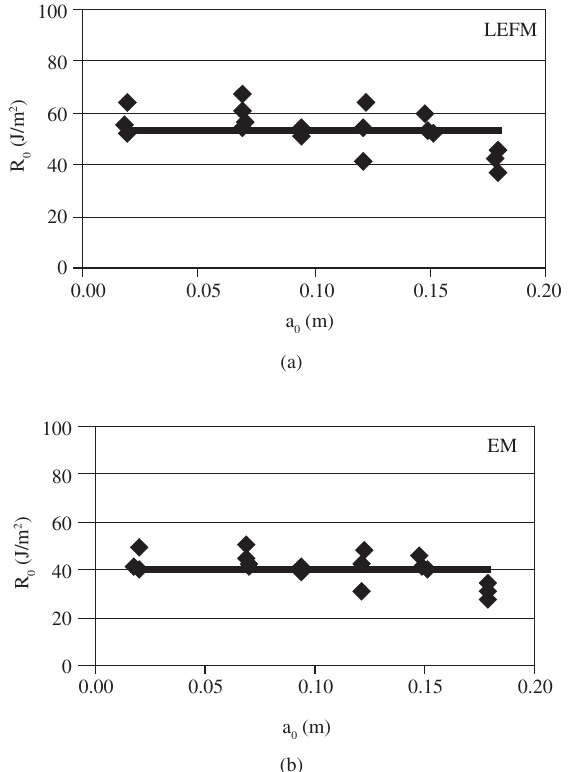
Figure 13. Initial crack propagation resistance, R b)